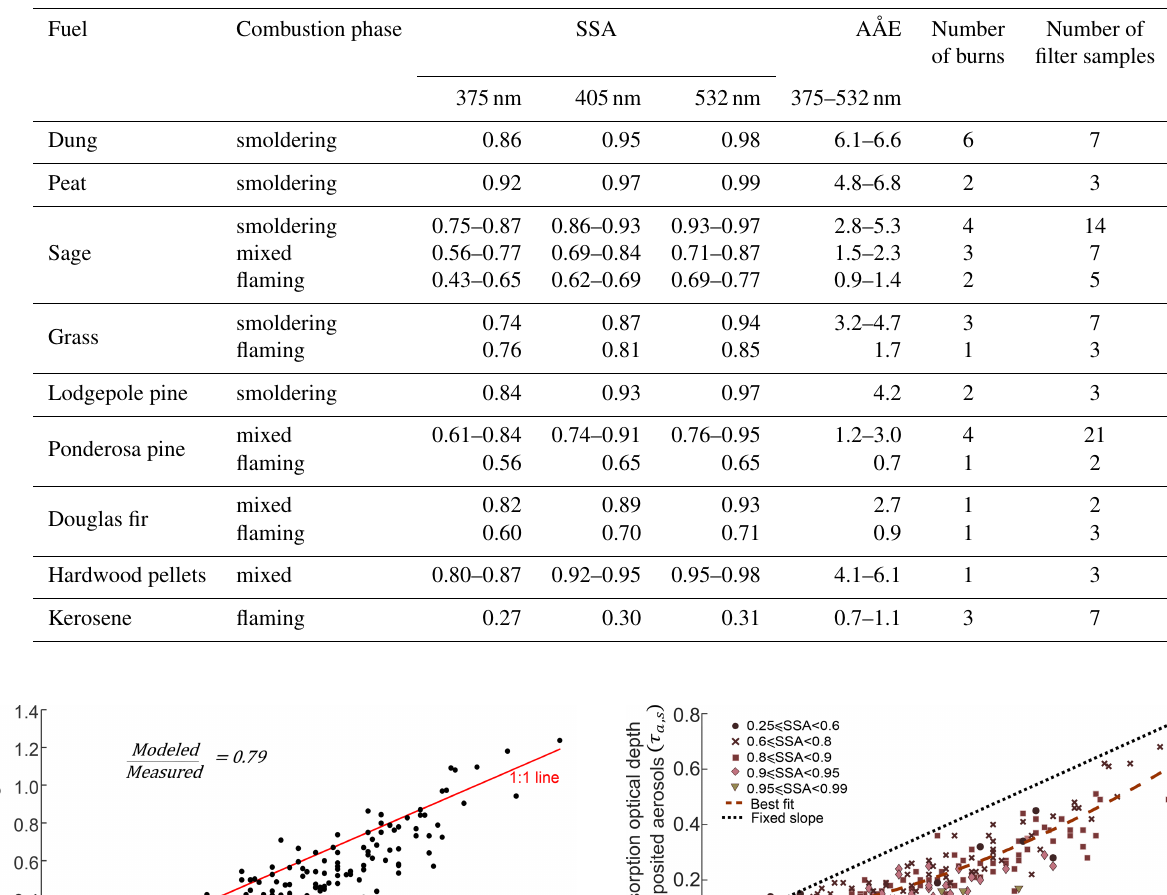
Table 1. Number of burns conducted and filter samples collected for each fuel type and combustion phase in this study. Intrinsic optical properties of emissions from each study condition are also given.